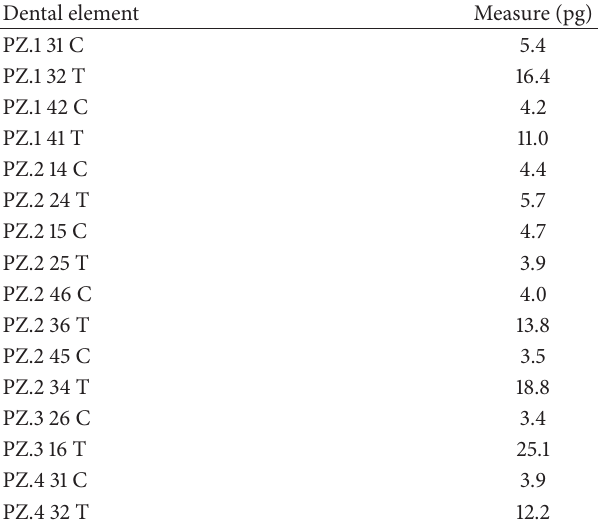
Table 1: SP levels in crevicular gengival fluid of four patients. In the column on the left side, we had specified the number of patient and the dental element number using the FDI system of nomenclature, “T”: test tooth, “C”: control site. In the right column, there is the SP measurement expressed in